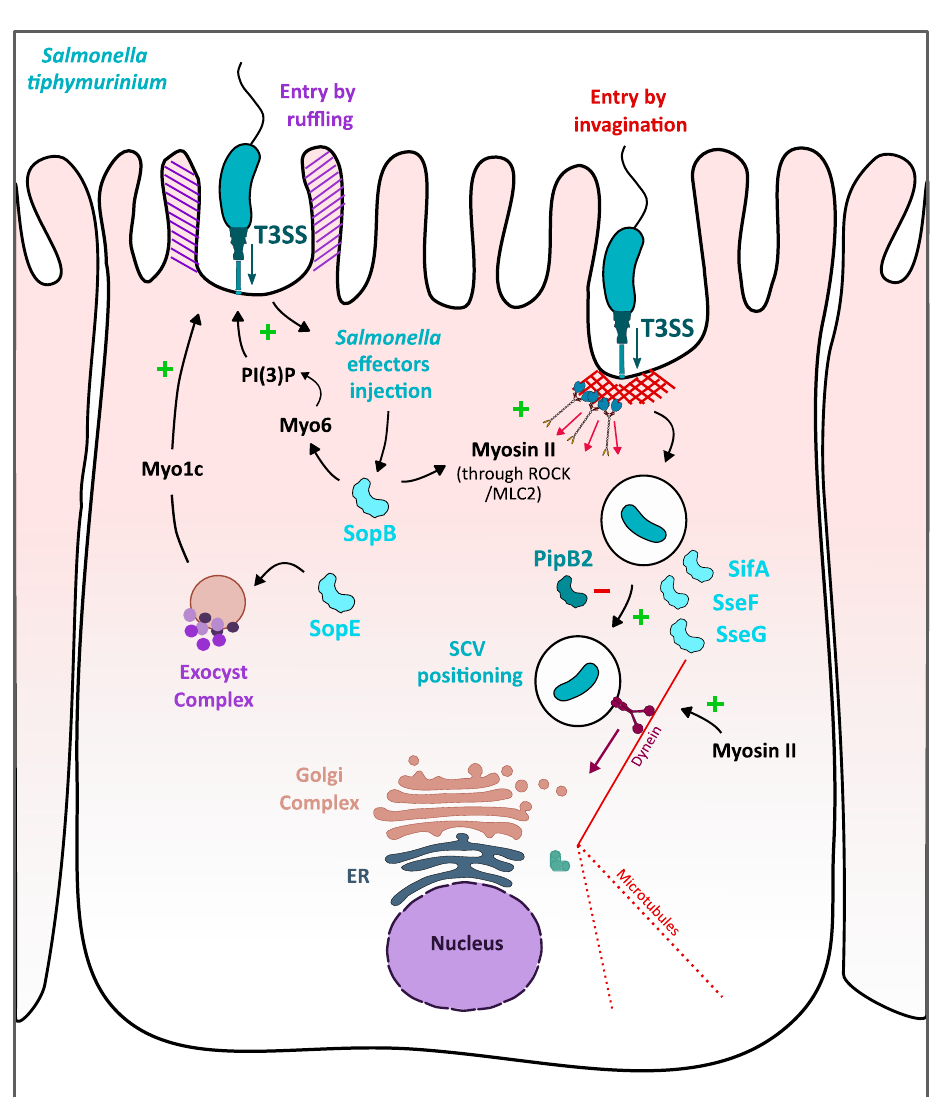
Figure 4. Role of myosins I, II and VI in S. typhimurium invasion and intravacuolar replication in epithelial cells. S. typhimurium enters the intestinal epithelial cells by triggering membrane ruffling (in purple strips) and invagination (in red strips). Both mechanisms are facilitated by myosins whose activity is induced by Salmonella injected effector SopB (light blue). In the “ruffling-dependent entry”, the role of myosin VI is indirect as it facilitates the recruitment of PI(3)P under the phagocytic cup, which in turn activates signaling pathways leading to recruitment of cytoskeletal proteins. Myo1c would also promote “ruffling-dependent entry” by recruiting additional membrane from the exocyst complex to elongate membrane ruffles. In the invagination process, the SopB/Rho-Rho-kinase/myosin II pathway generates force under the bacterial entry site hence pulling the bacterium inside the host. Then, Salmonella effectors, SseF, SceG and SifA, and myosin II are required for optimal positioning of the Salmonella -containing vacuole (SCV) to the perinuclear region for Salmonella replication.